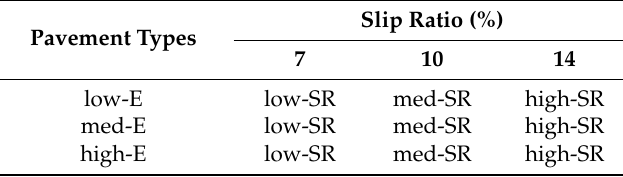
Table 5. Conditions of brake efficiency in different slip